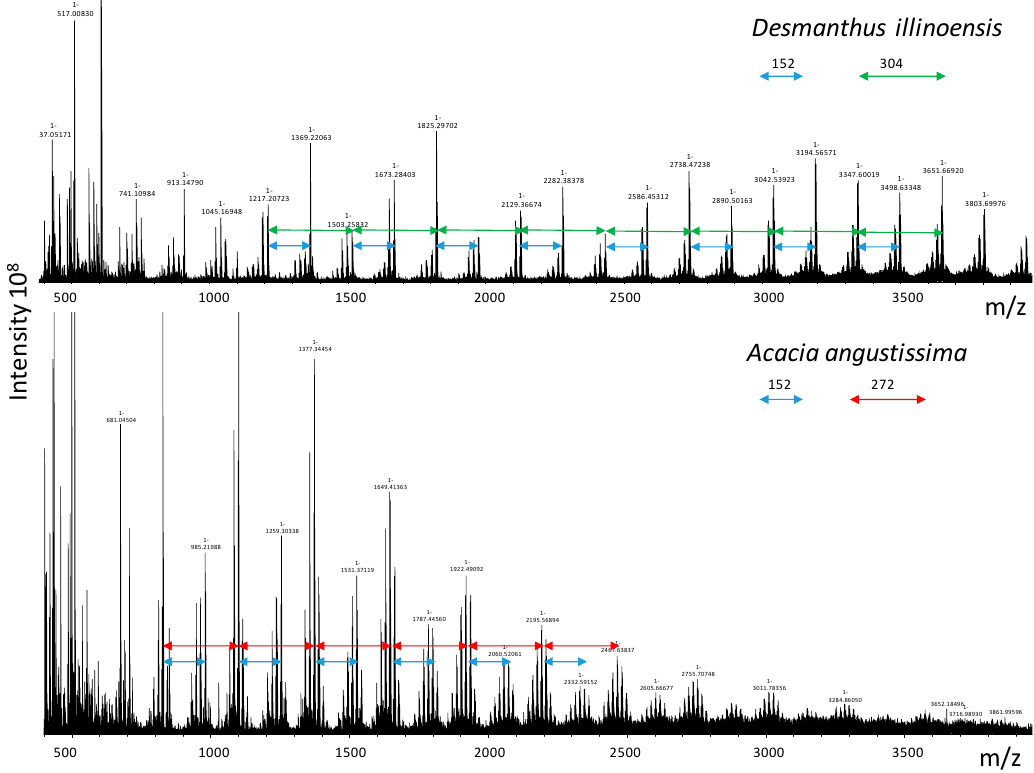
Figure 2. Representative ultrahigh resolution negative mode MALDI-MS data for CT. The top spectrum was obtained with CT from Desmanthus illinoensis and the bottom spectrum with CT from Acacia angustissima . The mass intervals between the clusters of peaks represent the characteristic subunits for the CT, with an interval of 304 typical of (epi)gallocatechin, an interval of 272 typical of fisetinidol, and an interval of 152 typical of gallate ester modification.